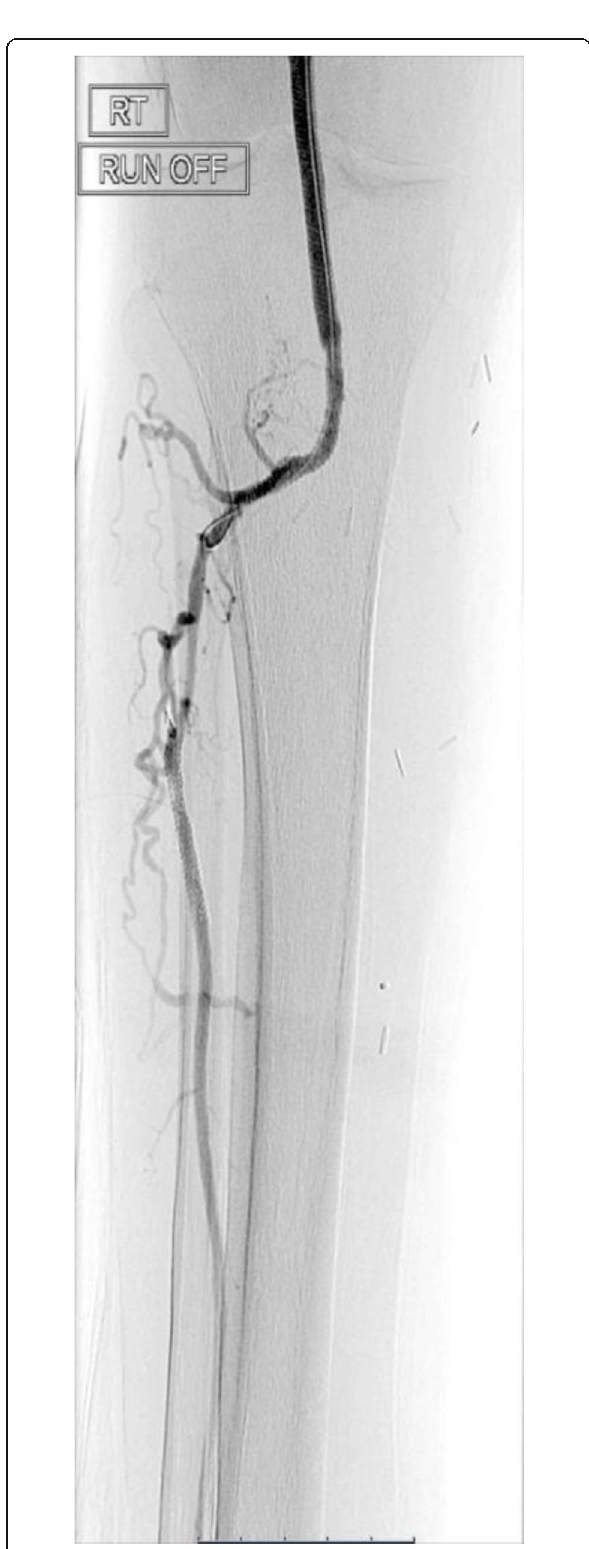
Fig. 7 Final runoff of the distal popliteal artery and the anterior tibial artery